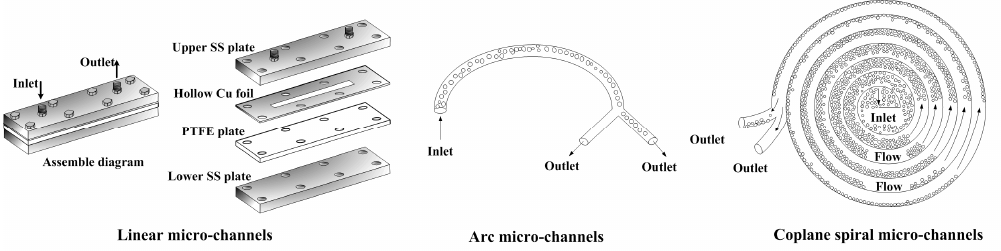
Figure 1. Linear asymmetric plate-type micro-channels (APM), arc, and spiral micro-channels used for demulsification.